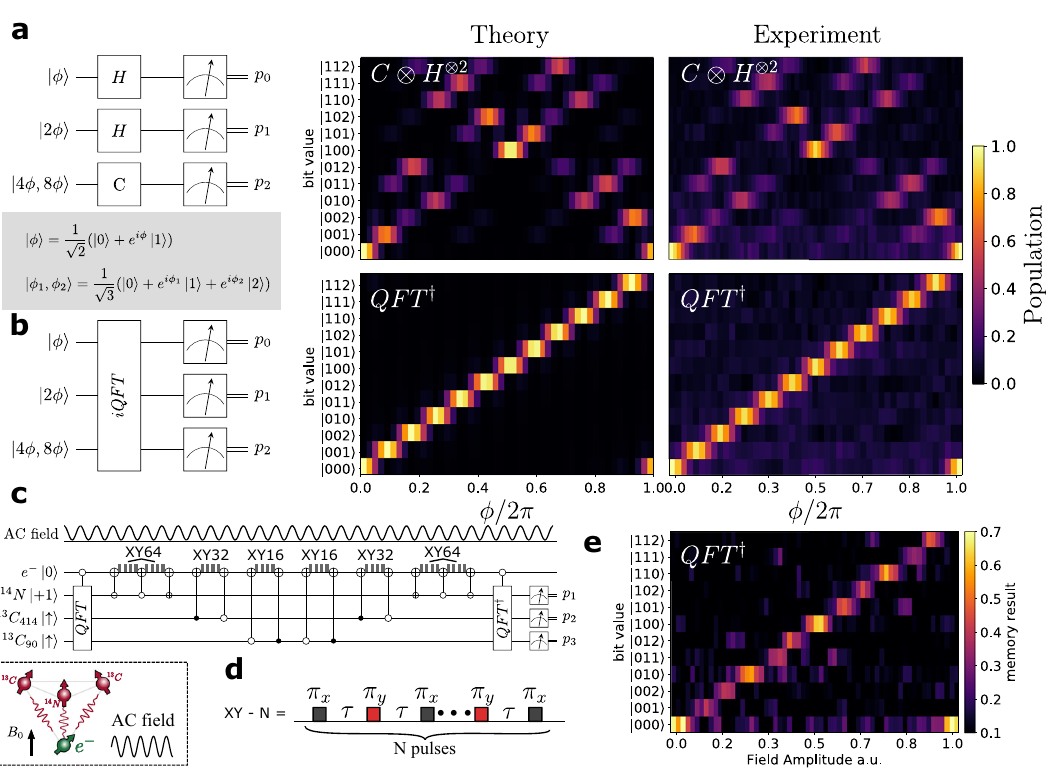
Fig. 2 Measurement outcome of the register after two readout methods and demonstration of high dynamic range AC fi eld detection with QFT † . a Quantum circuits of readout methods of register prepared in arbitrary phase state Ψ j i ¼ ϕ j i (cid:2) 2 ϕ j i (cid:2) 4 ϕ ; 8 ϕ j i using local single qubit (qutrit) Hadamard gates. Results of calculations and experimental realization of the circuits on our system. b Same using QFT † algorithm. Notably in the QFT † case there is no ambiguity between regions of phase 0 − π and π − 2 π . Additionally the QFT † prepares fi nal states which are close to the eigen states of the register, minimizing the loss of purity due to dephasing. c Schematic representation of the quantum circuit which serves for detection of the arti fi cial fi eld. d Realisation of XY-N detection scheme for AC fi eld sensing. e Measurement outcome of the memory